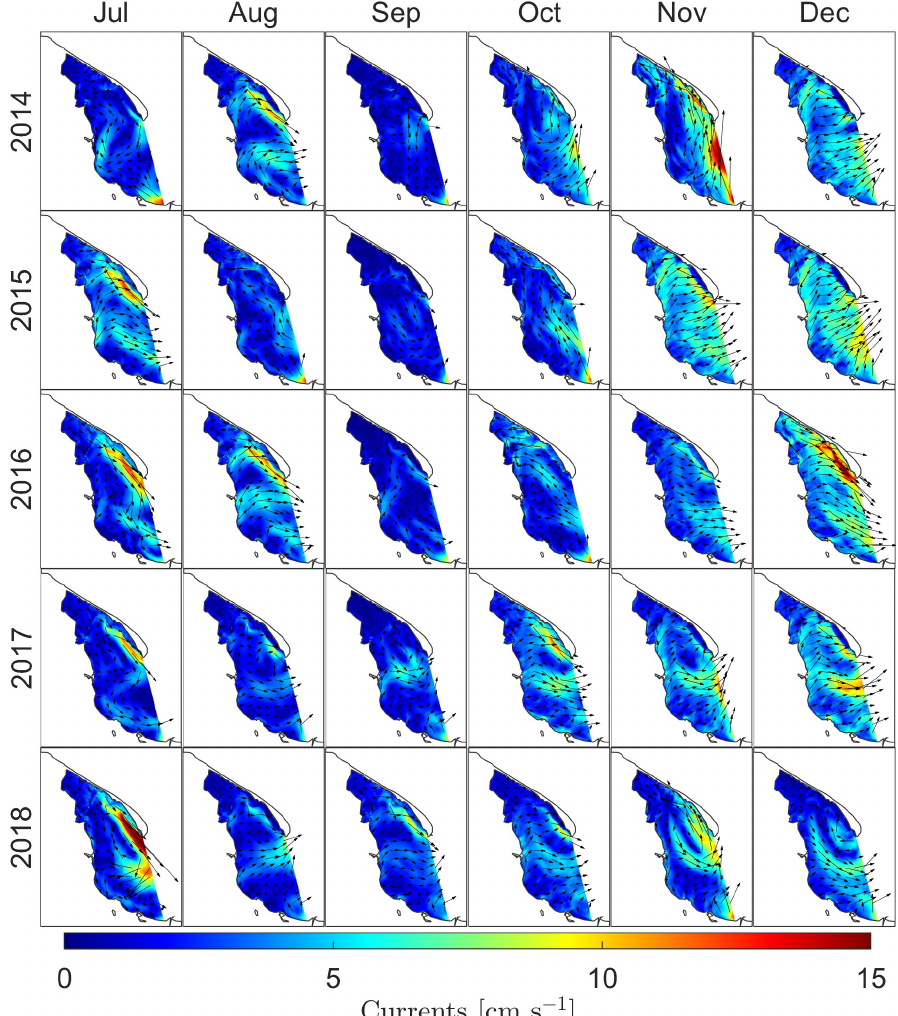
Figure A22. Monthly means of currents at surface level for separated years. July to